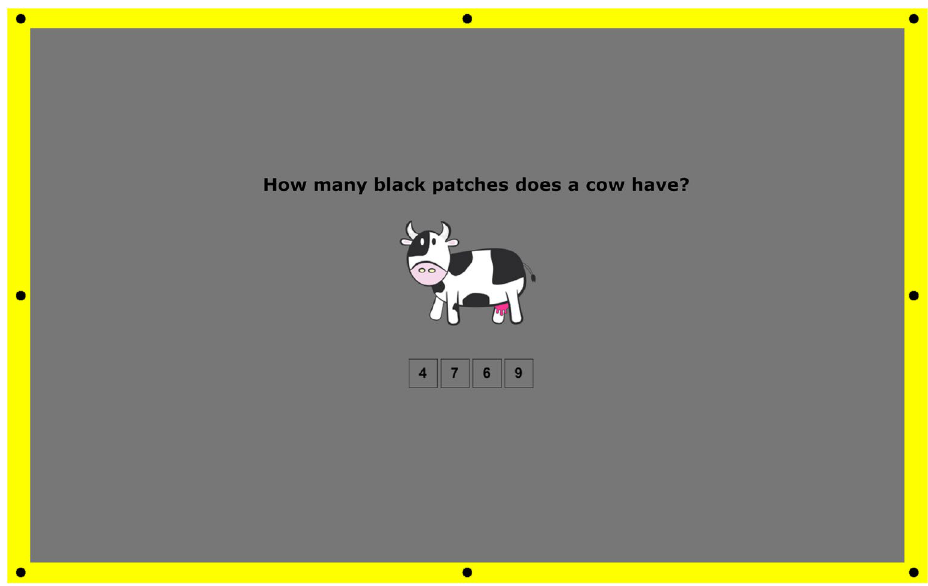
Figure 11. The example of the cognitive task used in our experiment. Central area (center of the screen): a cognitive task focusing the user’s attention and a box task with possible answers below. Yellow frame: an example of a colored frame that states a background for displayed discs. Elements placed on the frame (given in black color): stimuli in the form of discs, flickering with a frequency level of 1.5 Hz, 2 Hz, or 4